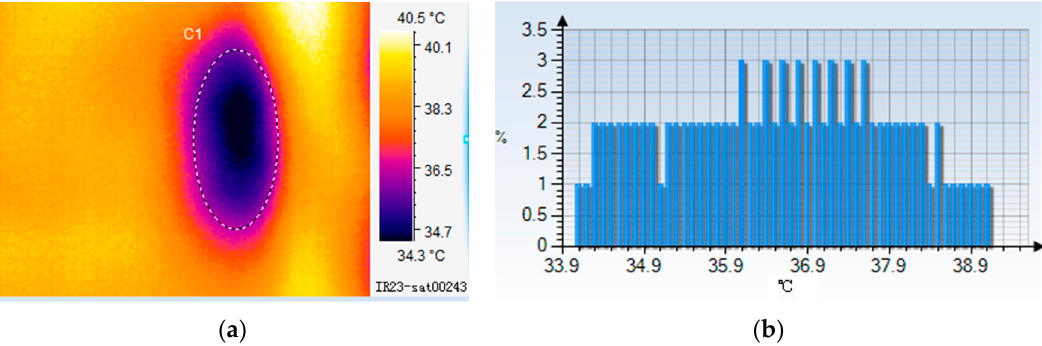
Figure 9. Infrared imaging and temperature distribution after irrigation at 11:20 a.m., ( a ) Infrared imaging; ( b ) Temperature distribution diagram.